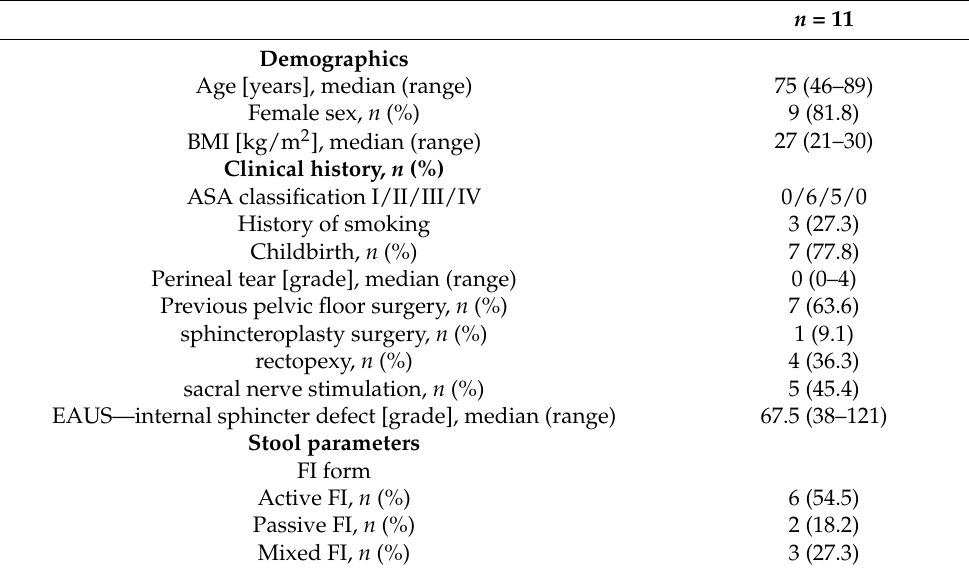
Table 1. Demographics and baseline characteristics. Baseline characteristics of patients undergoing Sphinkeeper procedure. ASA: American Society of Anaesthesiologists score; BMI: body mass index; EAUS: Endoanal ultrasound; FI: faecal